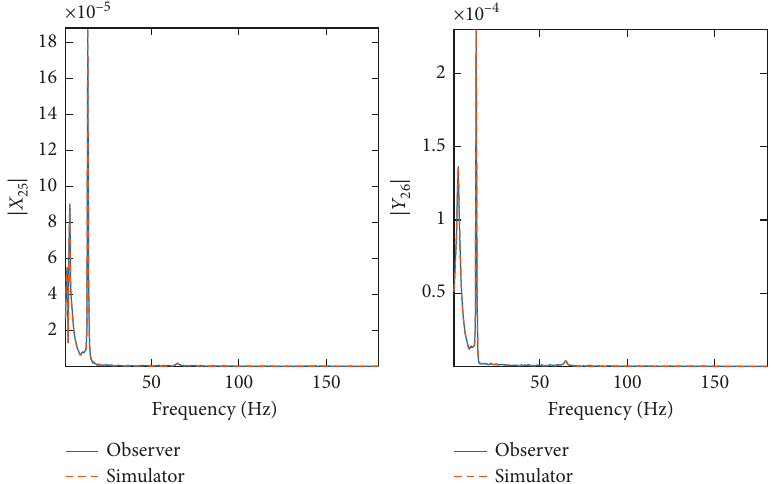
Figure 10: FFT of the elastic displacements of the